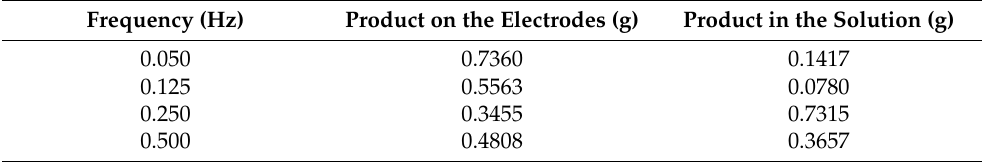
Table 1. The weight of the products on the electrodes and in the solution after 150 min electrosyn- thesis time with varying polarity reversal frequencies in 0.078 M H 3 BTC solution with 0.8 A cur- rent.